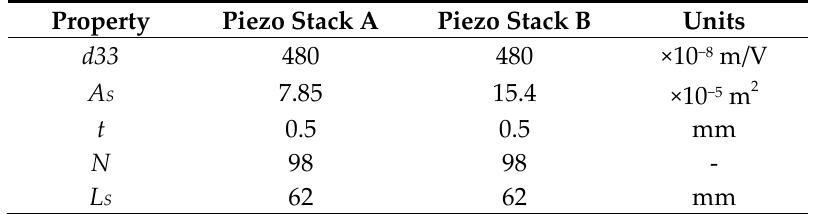
Table 1. Properties of the piezoelectric